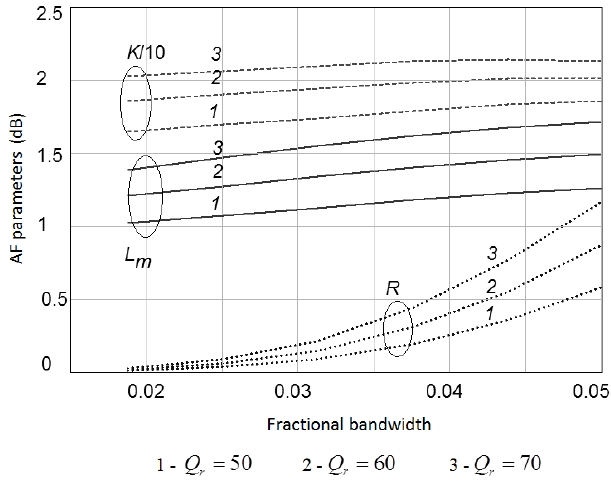
Fig. 4. AF parameters vs. fractional bandwidth at f 0 = 1.6 GHz, Q 02 = 1000, Q 01 = 150, Q r = 50 (curve 1), 60 (curve 2), and 70 (curve